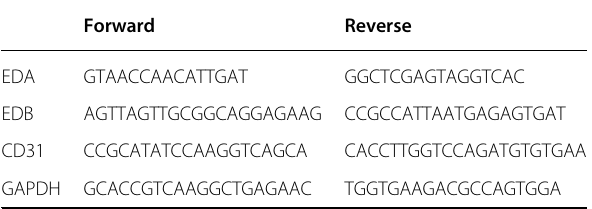
Table 3 Primers for quantitative real-time PCR. Table 4